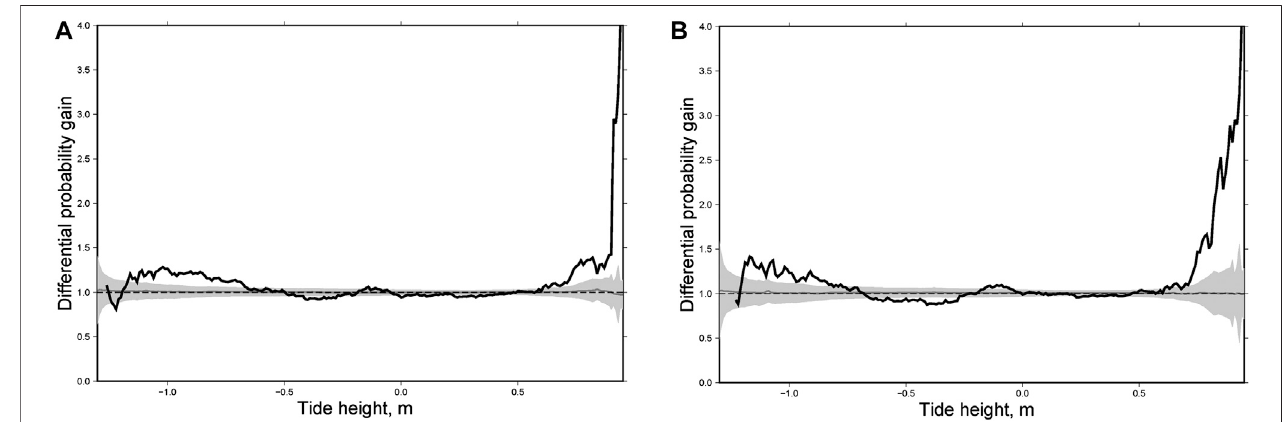
FIGURE9| IntegraldifferentialprobabilitygainfunctionforKamchatka:all16aftershocksequences (A) and14sequenceswithoutthosefortheM (cid:1) 7.8,December 15, 1971 and M (cid:1) 7.8, December 5, 1997 earthquakes (B) .